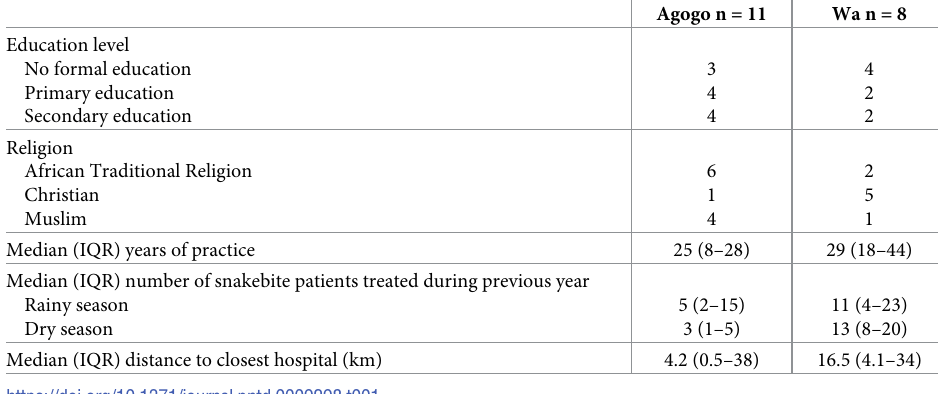
Table 1. Demographic characteristics and descriptive variables of THs per study